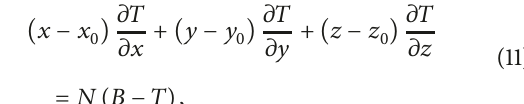
[40]; (formula (11)), and lineament maps from Bouguer data obtained after prediction through inversion using Oasis Montaj 6.3